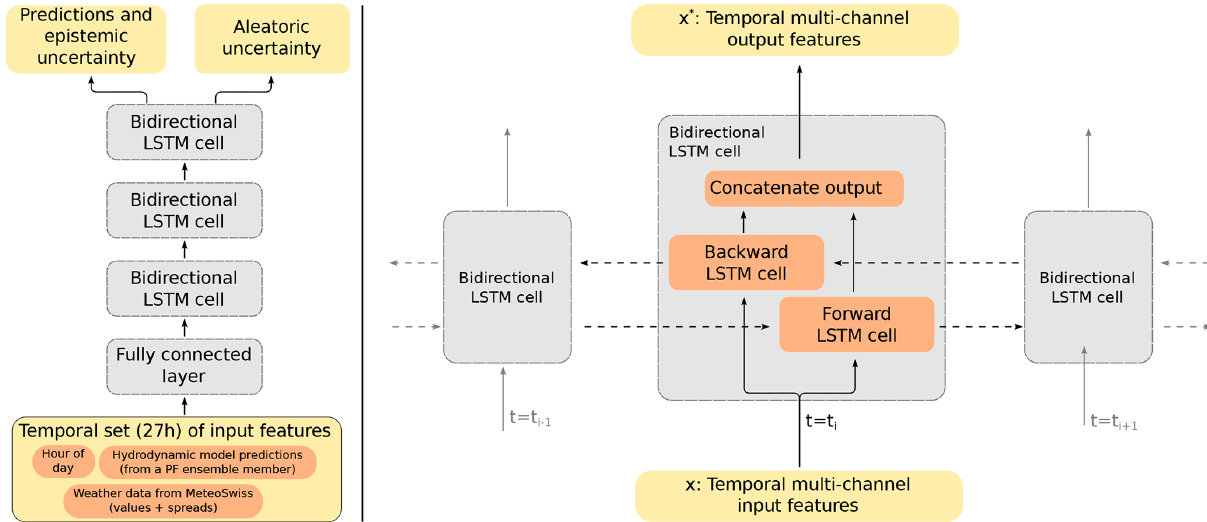
Figure 3. A diagram of the neural network we use in our model. On the left, we show the general processing of data within the neural network, and on the right, we show a schematic of a BiLSTM cell.